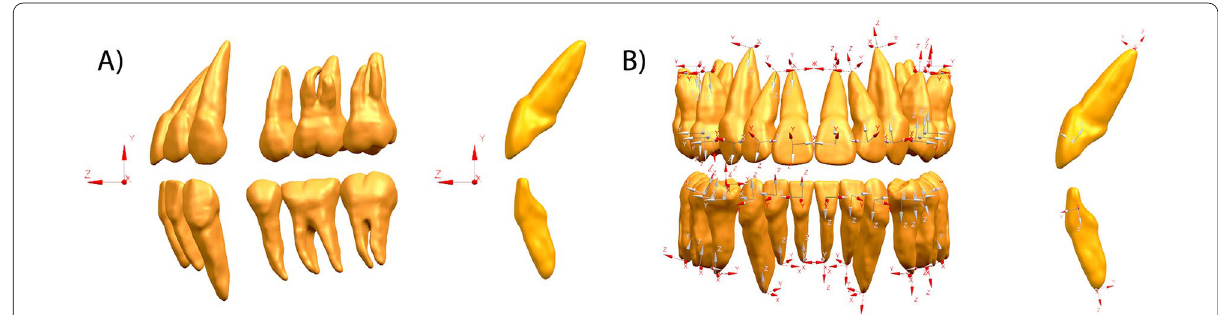
Fig. 2 Two coordinate systems were used to evaluate the tooth displacements. A Global coordinate system was set based on the occlusal plane and used to evaluate the vertical displacements of teeth. B Local coordinate system was set on the body center of the clinical crown and root apex of every tooth: x (mesiodistal direction), y (labial lingual direction), and z (tooth long‑axis direction). Local coordinates were used to analyze the labial/lingual and mesial/distal displacements of